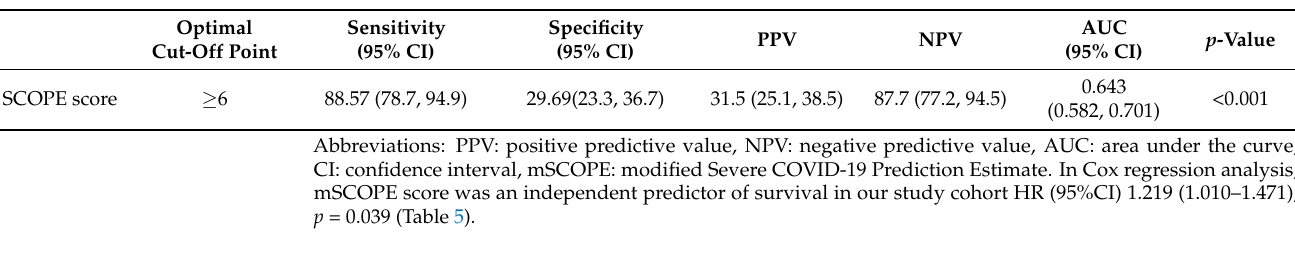
Table 5. Univariate and Multivariate Cox Regression